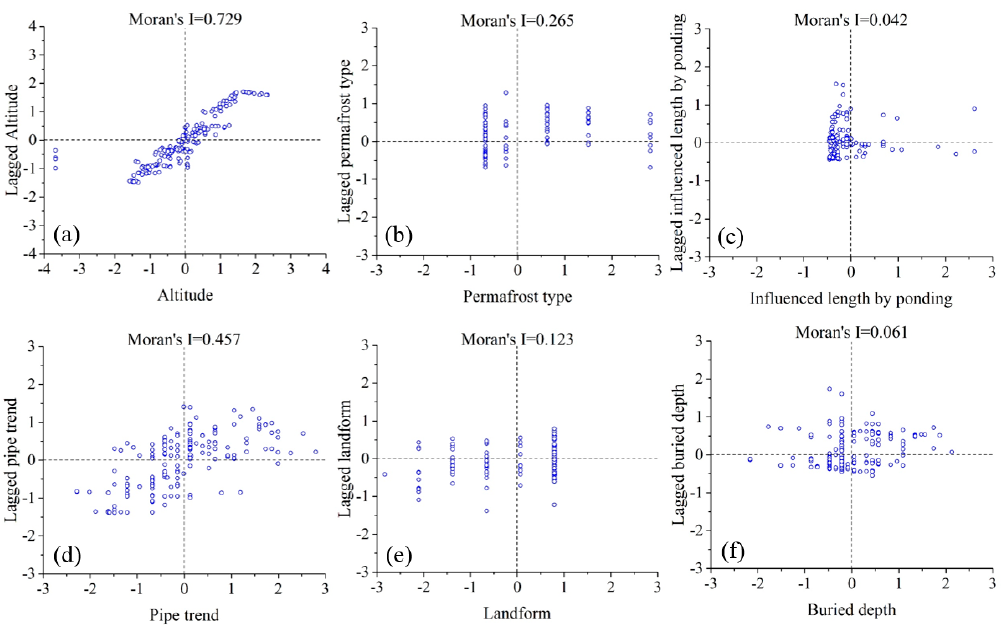
Figure 7. Scatterplots of Moran’s index (Moran’s I) of altitude ( a ), permafrost type ( b ), pond length ( c ), pipe orientation ( d ), landform type ( e ), and buried pipe depth ( f ).